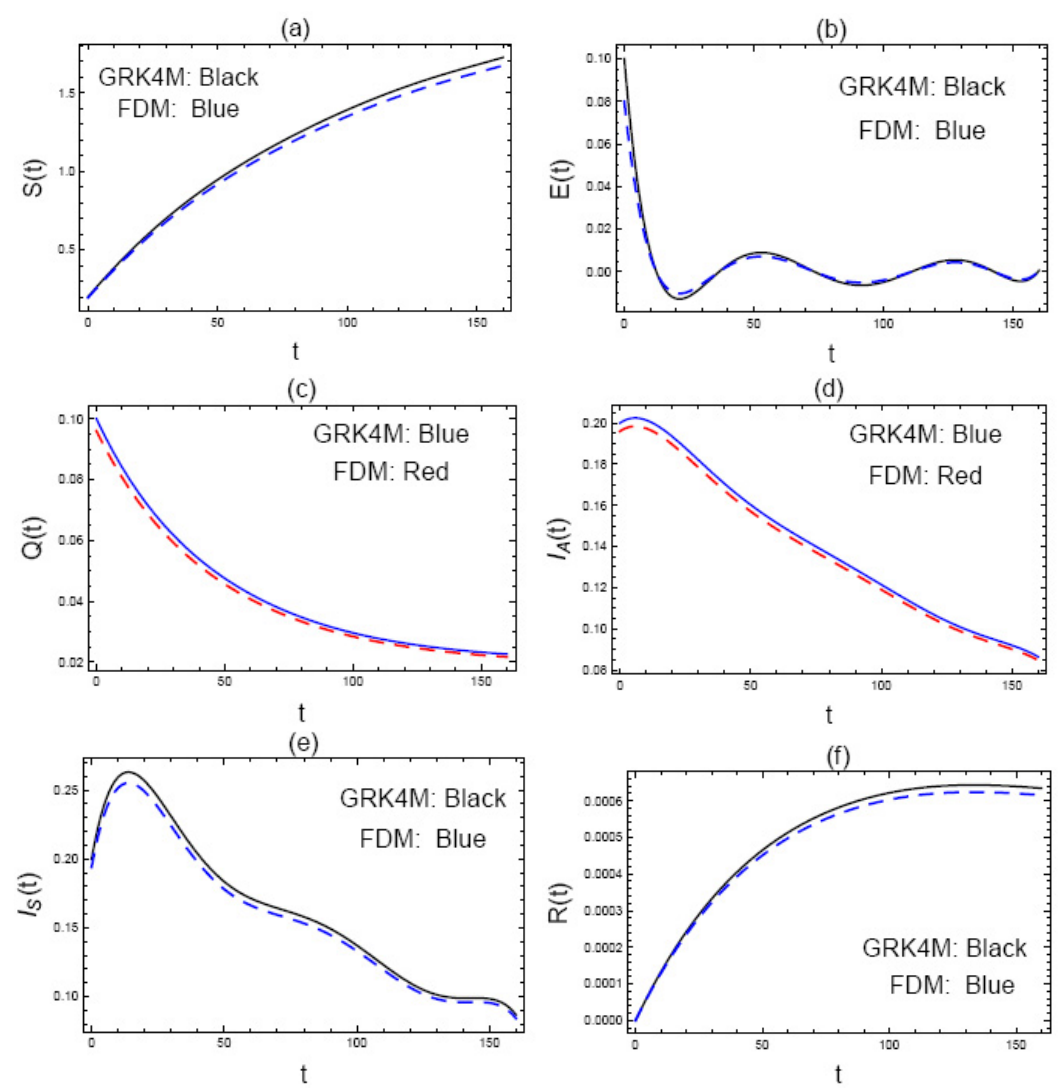
Figure 6. Comparison of the solution obtained by GRK4M and FDM at α = 0.94 ( a – f